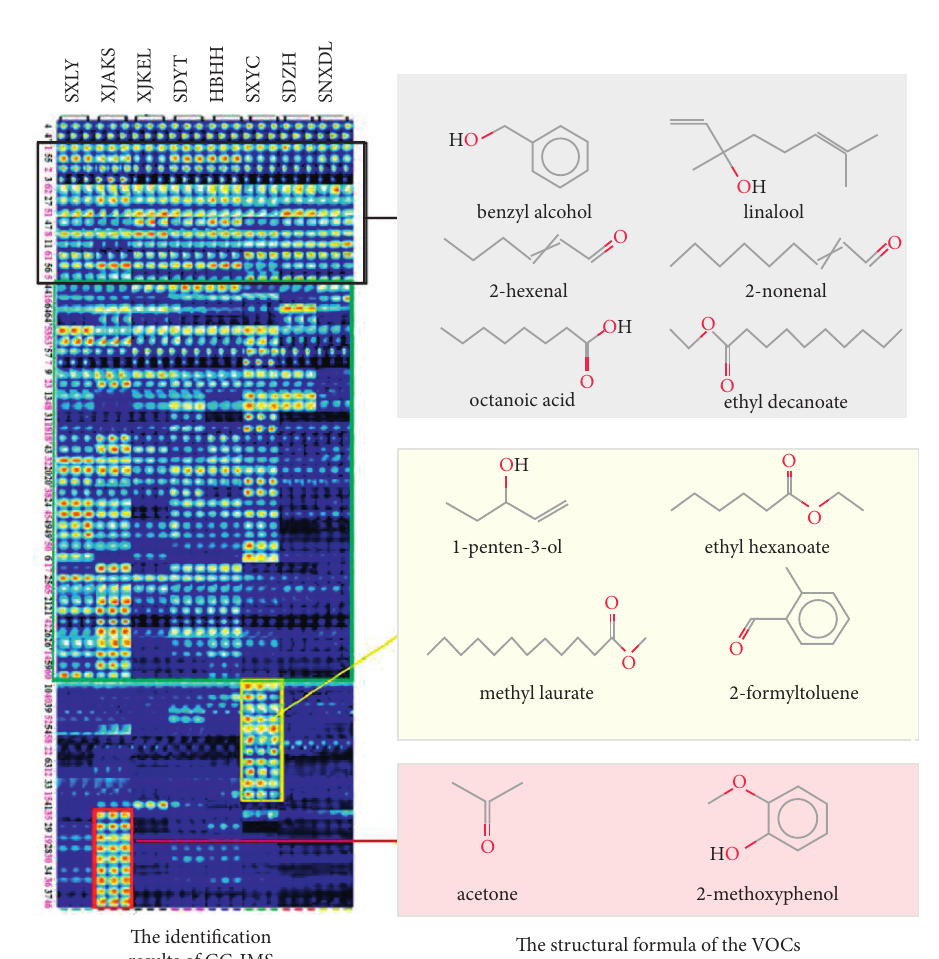
Figure 9: The common and specific VOCs for the eight cultivars of winter jujubes (SNXDL, SDZH, HBHH, SDYT, XJKEL, SXLY, SXYC, and XJAKS).